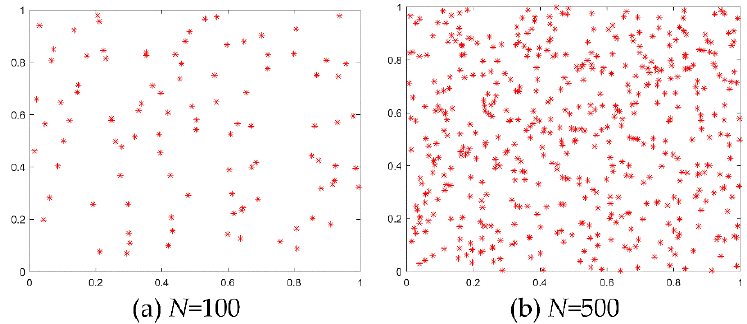
Figure 8. Pwlcm map sampling point distribution.